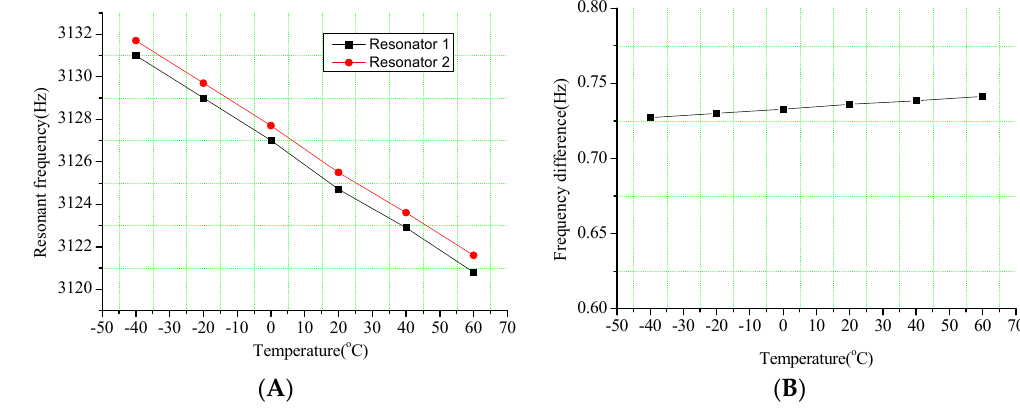
Figure 11. Frequency variations of resonators with temperature. ( A ) Frequency variations of resonators with temperature from − 40 °C to 60 °C; ( B ) Frequency difference variations with temperature from − 40 °C to 60 °C.